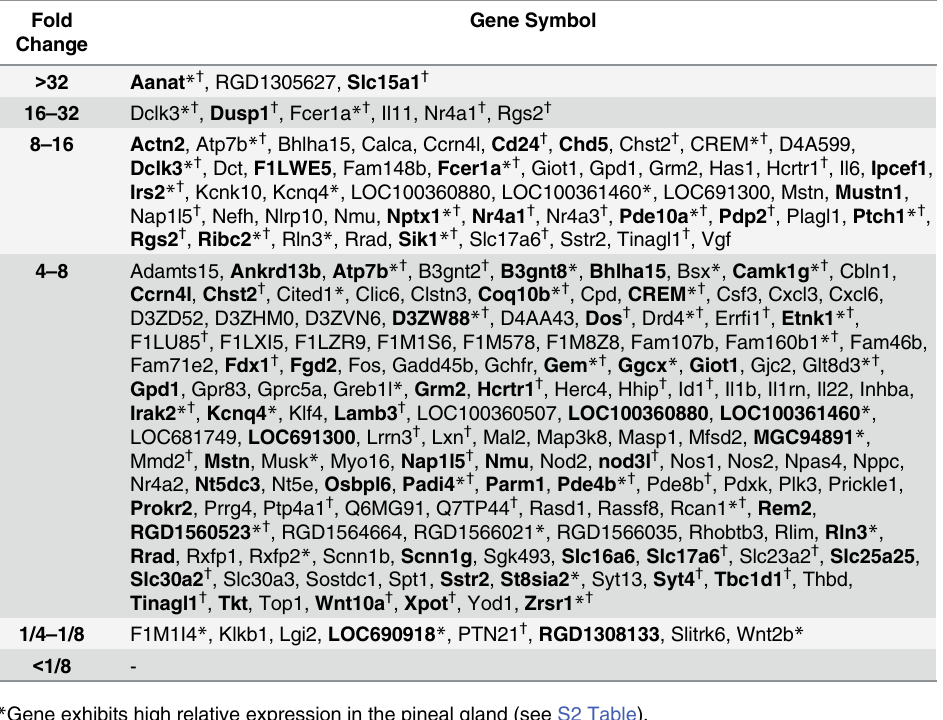
Table 3. Genes significantly differentially expressed in pineal gland tissues in response to in vitro treatment with NE or DBcAMP (adjusted-p < 0.001). Genes that exhibit strong differential expression in both the NE and DBcAMP analyses are listed in bold (genes are classified by the least-extreme fold change across the two analyses). A complete list of all genes with fold changes, p-values, and normalized expression estimates is available in the SI (S3